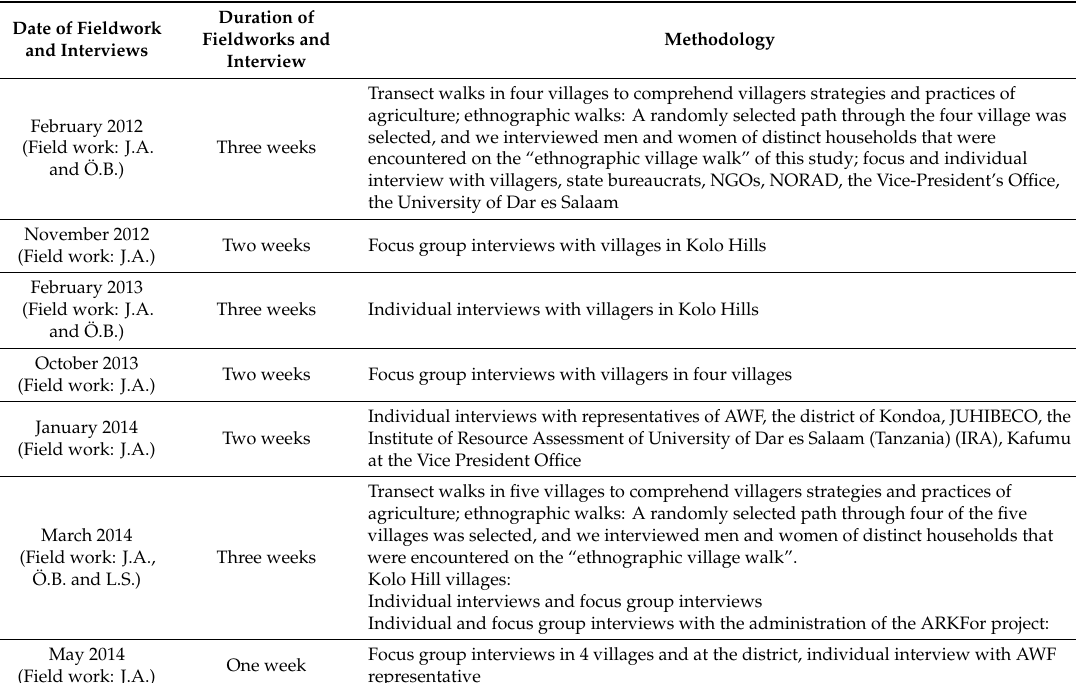
Table 2. Fieldwork